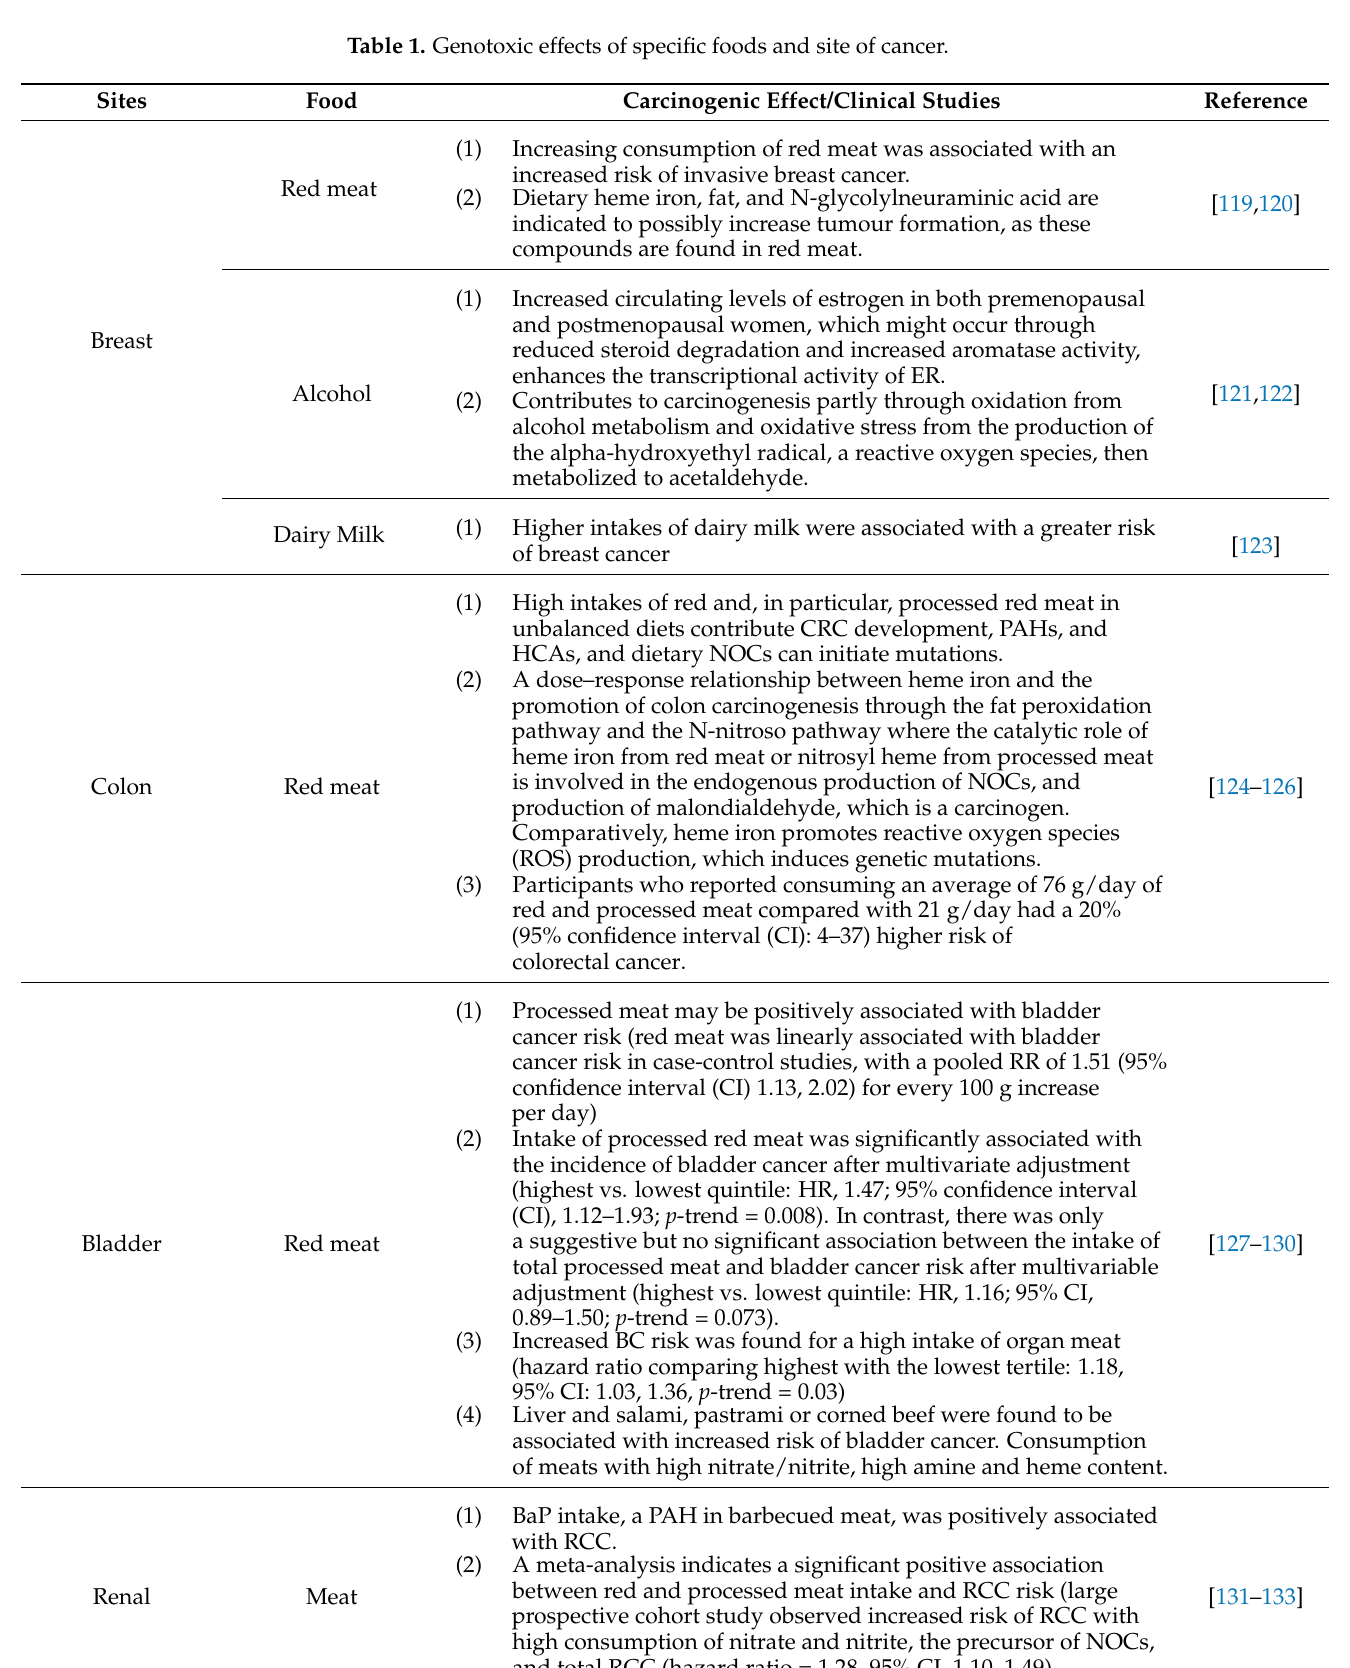
Table 1. Genotoxic effects of specific foods and site of